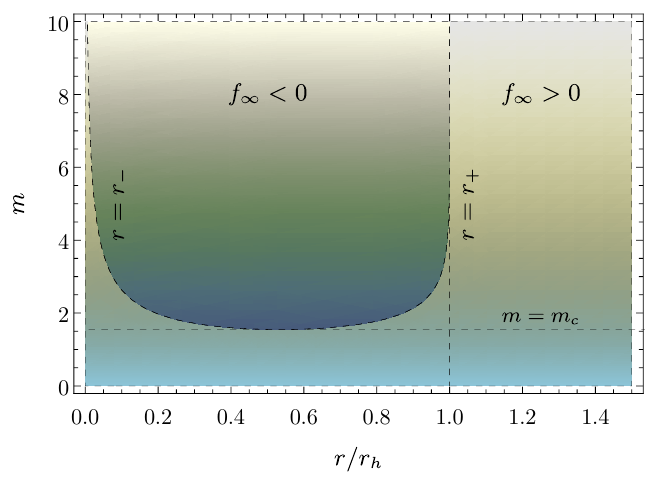
Figure 7 . Density plot of the lapse function f ∞ ( r ) , highlighting its positivity for increasing values of the mass parameter m and as a function of the radial coordinates in units of r the figure r and r denote the inner and outer horizon, respectively. For r > r − + lapse function f ( r ) is strictly positive. The causal structure is instead non-trivial for m ≥ m ∞ where f ( r ) can also be negative or vanish. Specifically, the lapse function is negative between ∞ the two horizons, positive outside, and vanishes on the boundary. Thus, for masses m/m than, equal or less than the critical value m